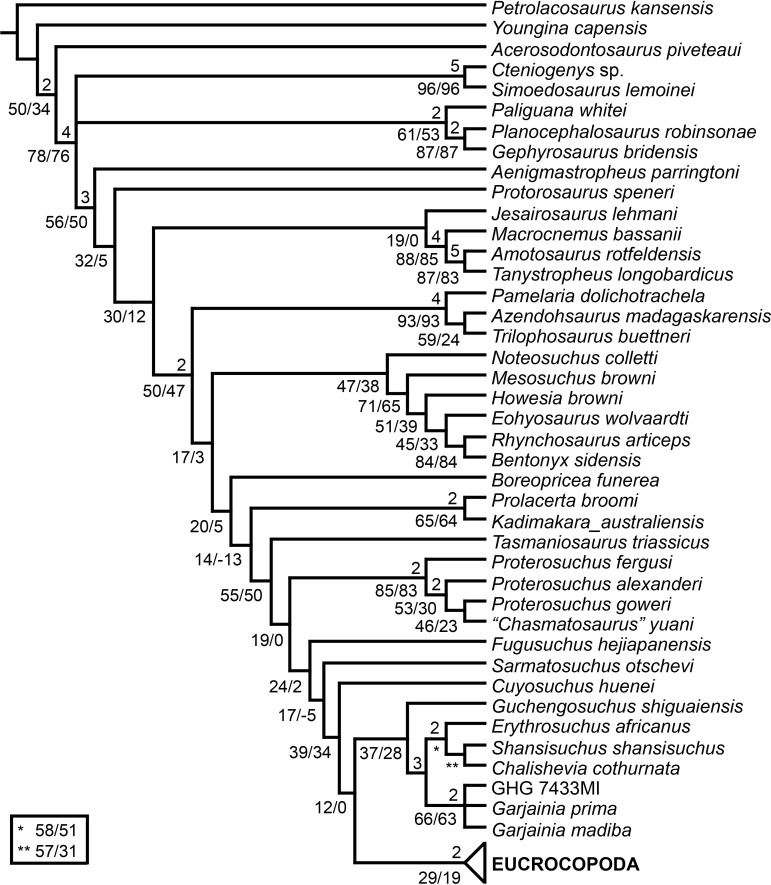
Branch support values shown on the strict reduced consensus tree recovered from analysis 3 after the a posteriori pruning of Kalisuchus rewanensis and Asperoris mnyama.Numbers above internal branches are Bremer support values above 1 and numbers below internal branches are absolute (left) and GC (right) bootstrap frequencies. Eucrocopodans have been merged into a single terminal in this tree.